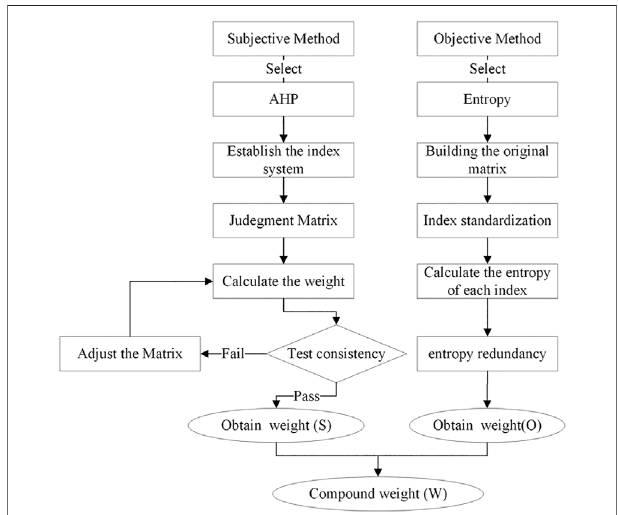
FIGURE 2 | Flow chart of weight